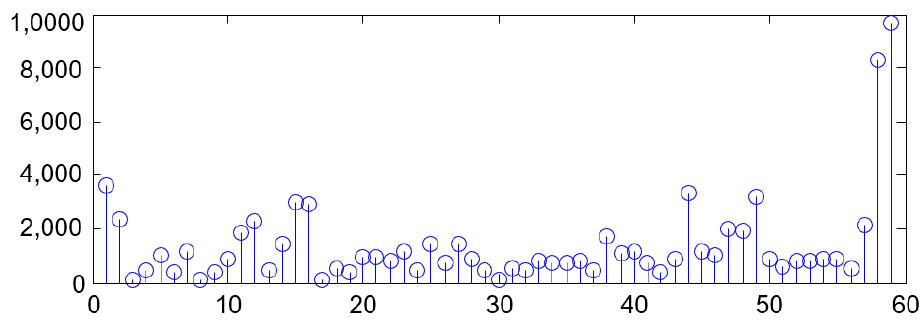
Figure 7. LBP histogram of ship.